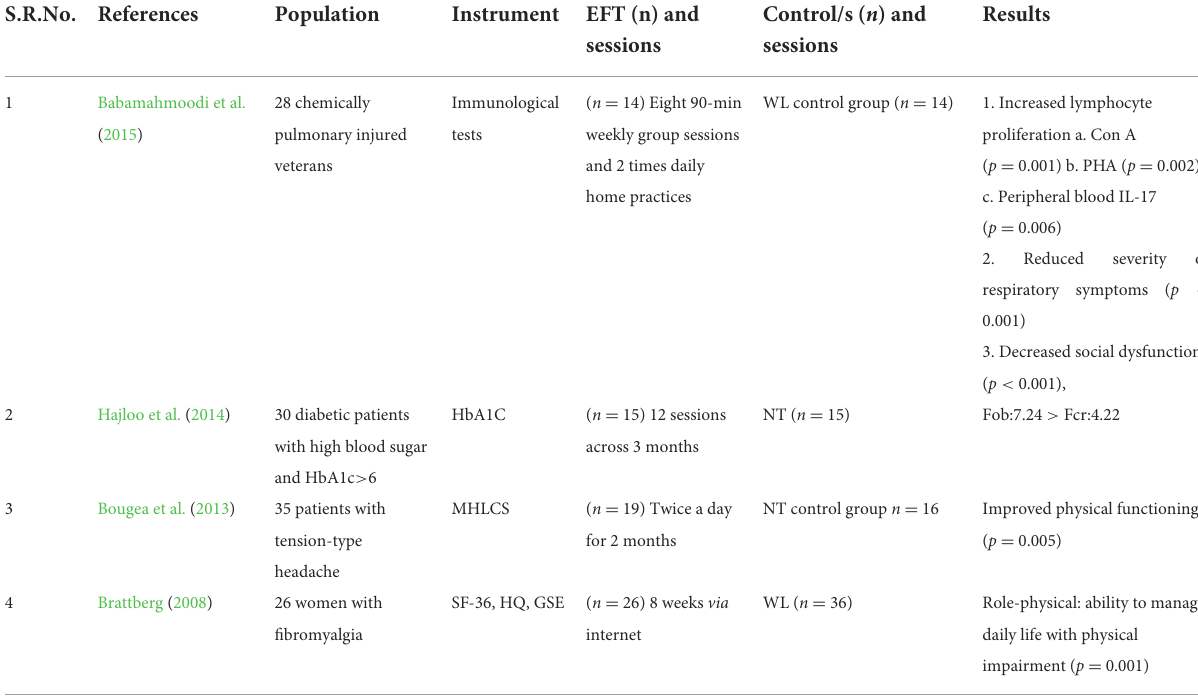
TABLE 12 RCTs assessing other physical